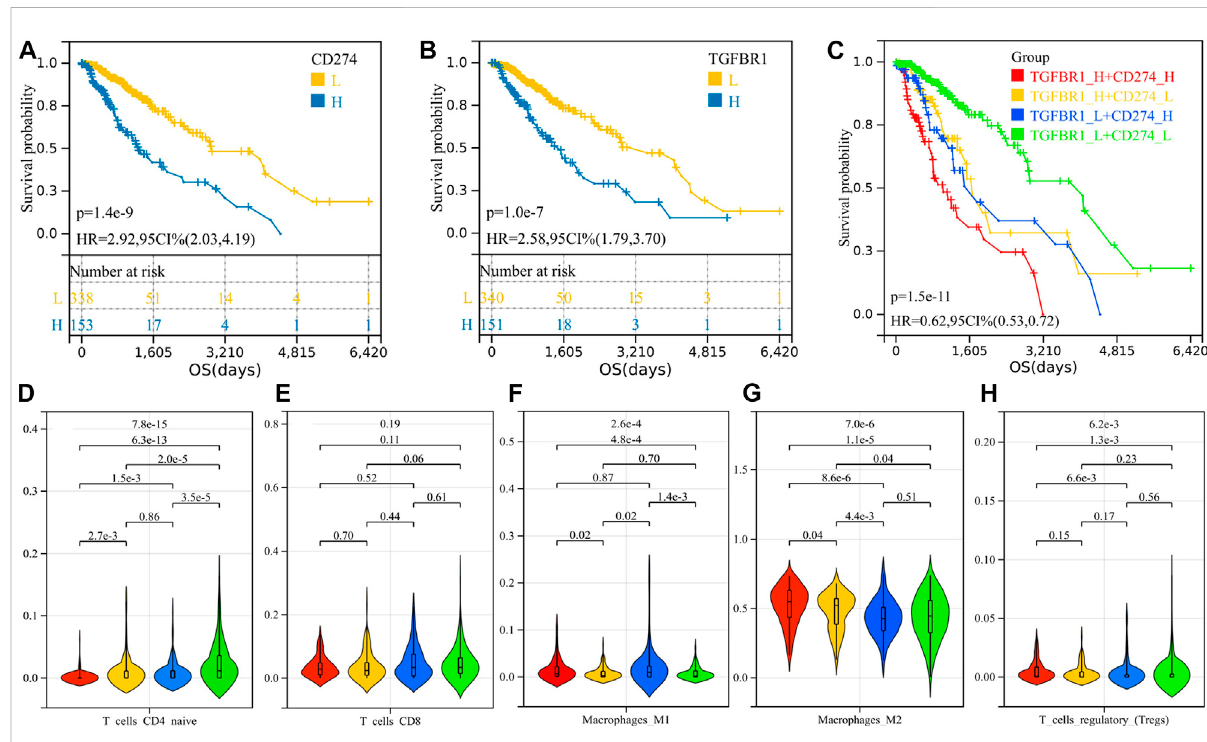
FIGURE 8 Survival analysis of PD-L1 and TGFBR1 and comparison of immune cell in fi ltration between groups. (A) K-M curve for PD-L1; (B) K-M curve for TGFBR1; (C) K-M curve for patients with different TGFBR1 and PD-L1 expression levels; and (D – H) immune cell in fi ltration between